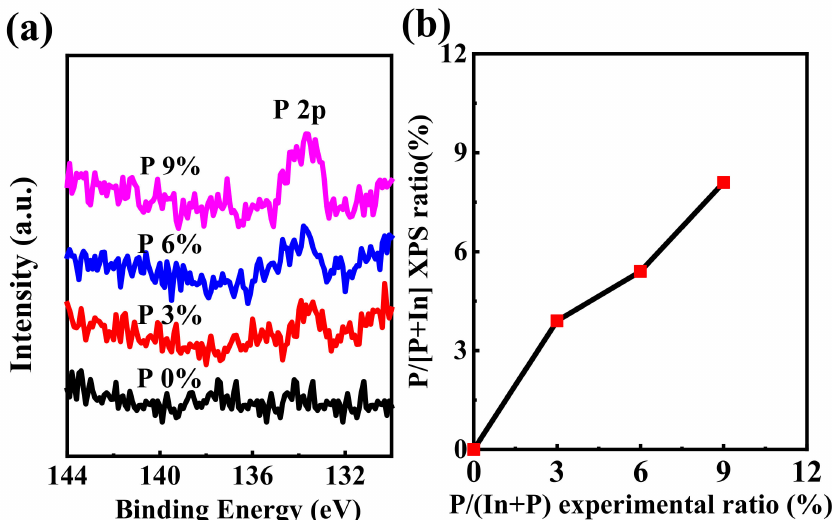
Figure 4. XPS spectra for the IPO films with different P-doping contents. ( a ) P 2p. spectra, and ( b ) P-doping ratio between solution and